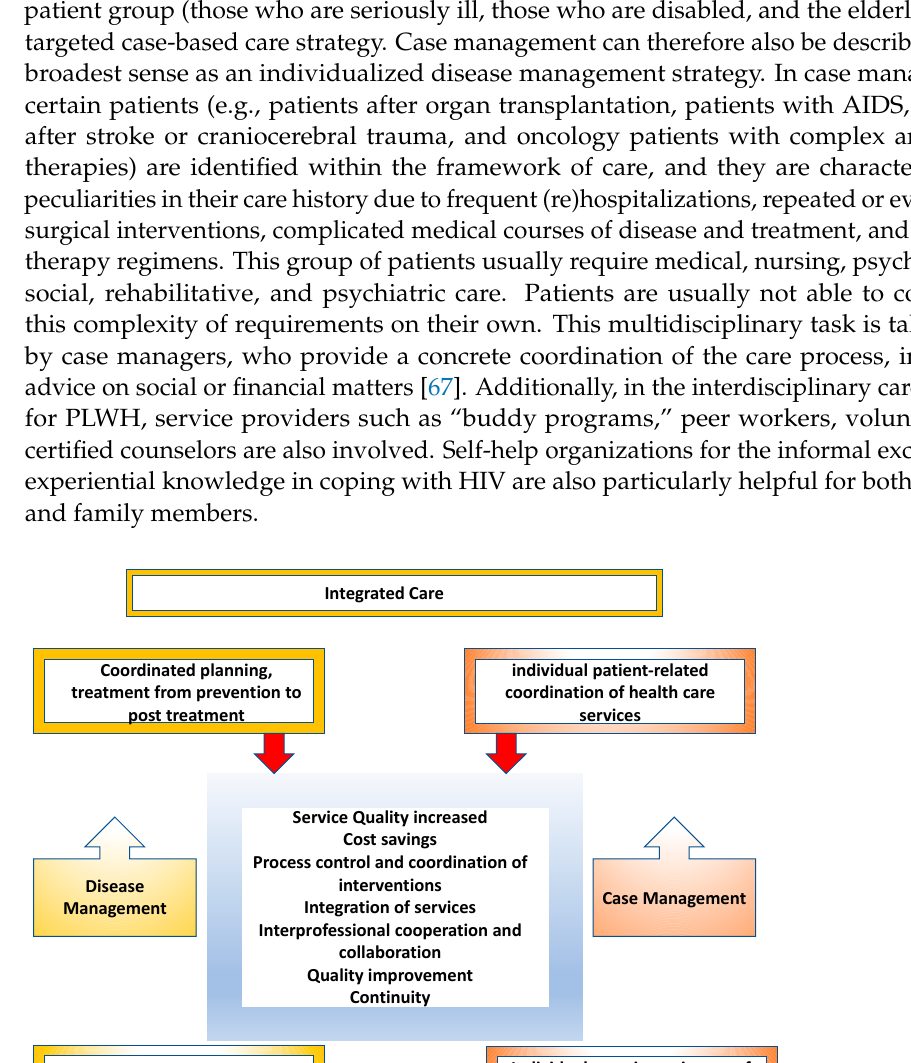
Figure 3. General complexity of people with chronic diseases (own presentation). The complexity of HIV (Figure 4) has shifted due to the potential for rapid diagnosis and immediate treatment [70]. Although ART has improved in terms of dosing frequency and low side effects, adherence to the treatment regimen remains a challenge for many PLWH and is the main reason for ART failure [71]. If viral replication suppression is in- adequate, the risk of developing resistance to ART agents increases [72]. Furthermore,